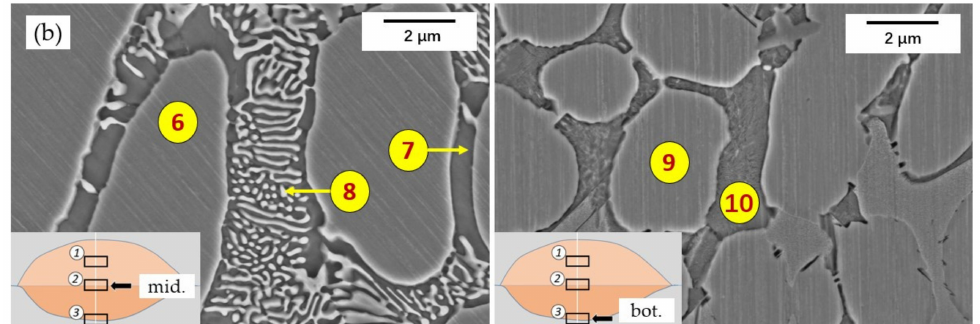
Figure 10. SEM microstructure of middle area and transition area in the cladding layer: ( a ) 55 NiTi cladding layer; ( b ) 55 NiTi + 5 Ni cladding layer.